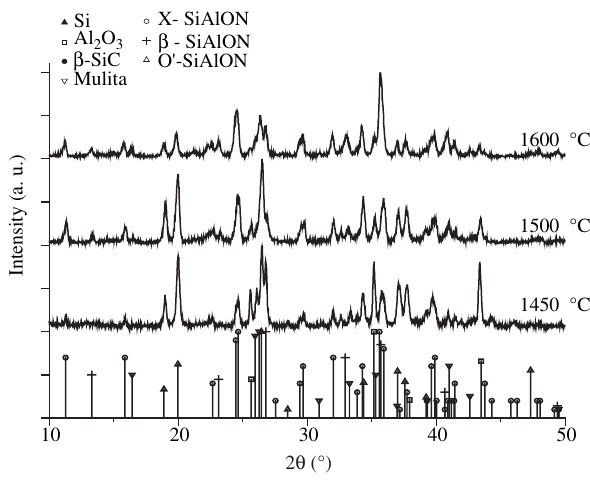
Figure 4. X-ray diffraction patterns of specimens after pyrolysis at three different final temperatures.